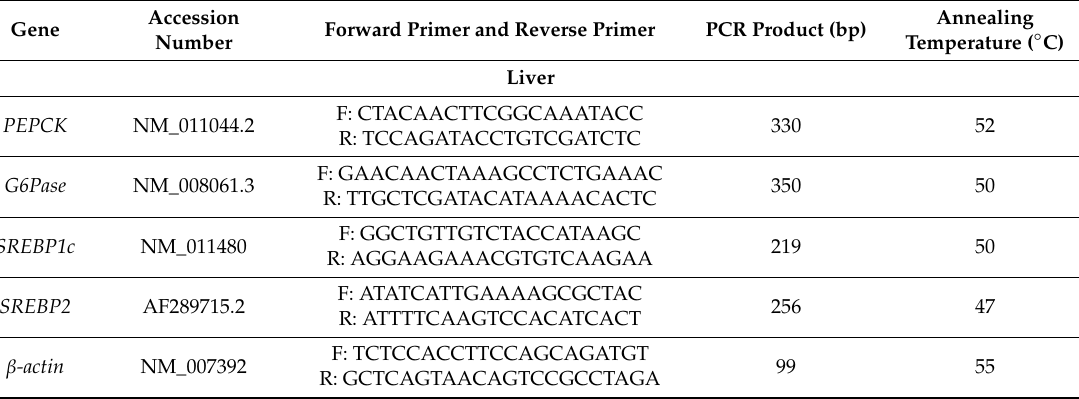
Table 1. Primers used in the present